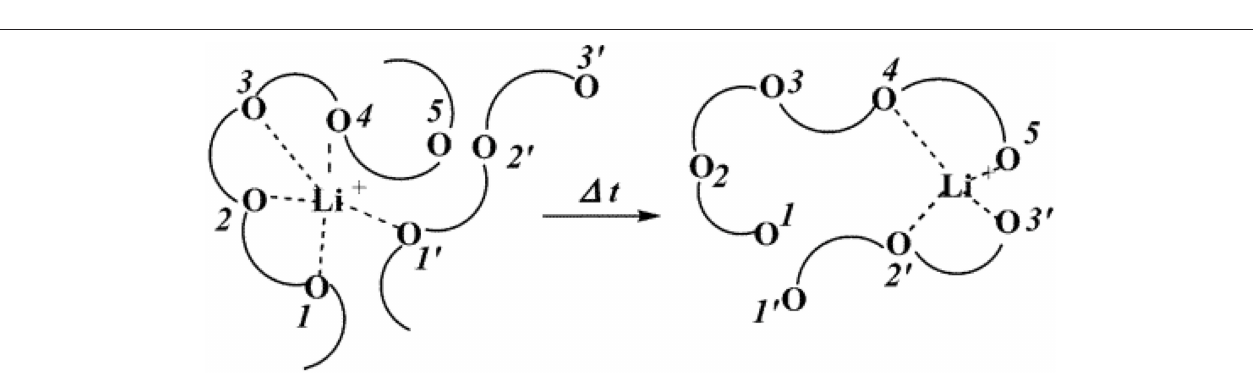
FIGURE 2 | The number of published sci-hech articles in the polymer-based solid electrolyte over a period of 19 years from 2000 to 2019.